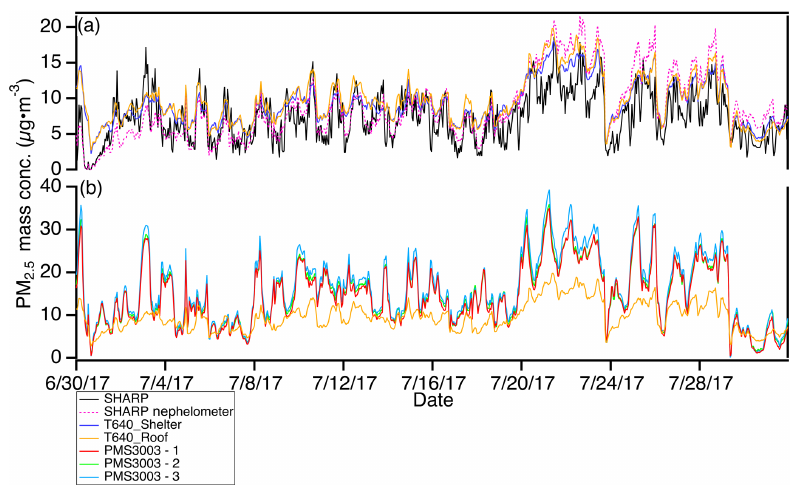
Figure 5. Comparison of hourly aggregated PM 2 . 5 mass concentrations (µgm − 3 ) (a) among the SHARP, the SHARP’s nephelometer, the two T640 sensors (one unit sitting on the roof, “T640_Roof”; the other unit installed in the OAQPS shelter, “T640_Shelter”), from 30 June to 31 July 2017 at U.S. EPA RTP, and (b) between the T640 sitting on the roof (T640_Roof) and the three uncalibrated PMS3003 sensor packages during the same period at the same